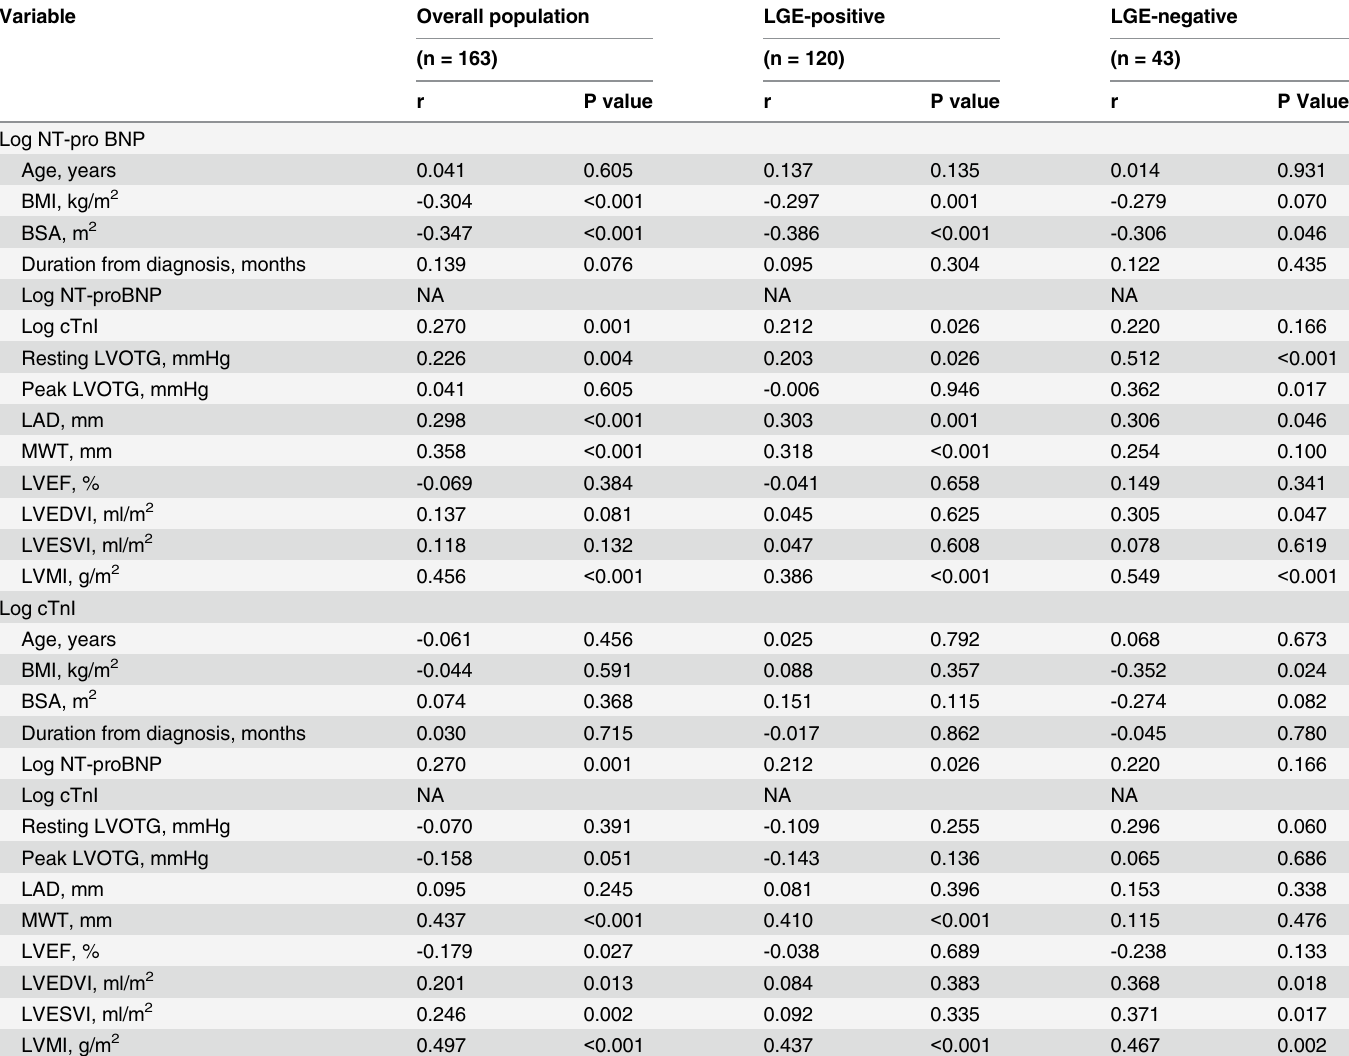
Table 5. Correlates of peripheral levels of NT-proBNP and cTNI in patients With